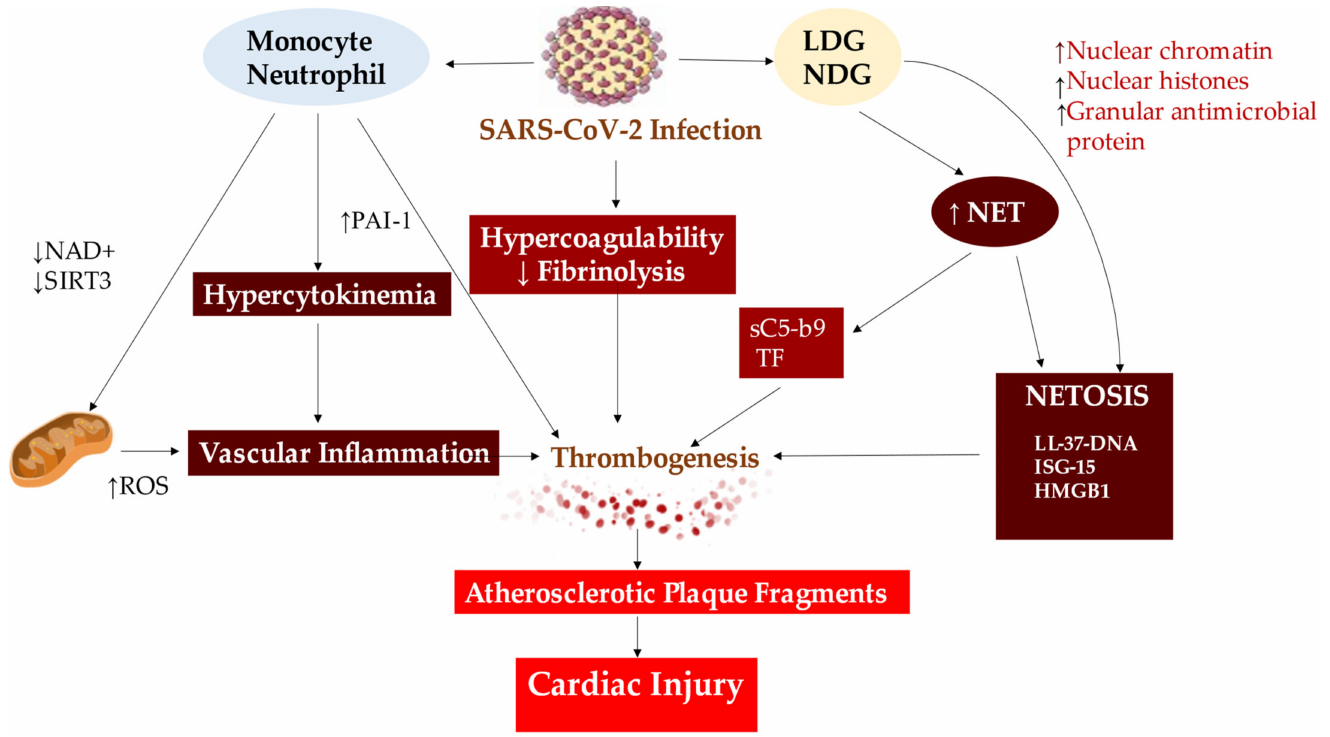
Figure 5. The mechanism leading to cardiac injury from NETs formation in patients with severe COVID-19 is determined by vascular inflammation, thrombogenesis and NETOSIS through the insta- bility of the atherosclerotic plaque. Abbreviations: HMGB1, mobility group box; ISG-15; interferon- stimulated gene; LDG, low-density granulocytes; NDG, normal density granulocytes; NAD, nicotin adenin dinucleotide; ROS, reactive oxygen species; SIRT3, Sirtuin 3. Other abbreviations in previous figure. ↑ , increase; ↓ ,